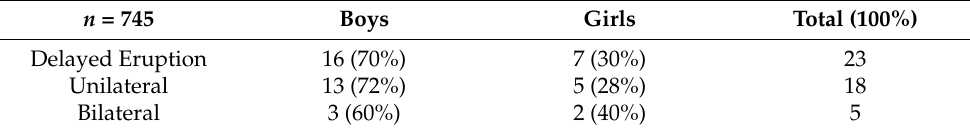
Table 1. Frequency distribution of delayed eruption cases according to gender. Delayed Eruption 23 Gender (3.09%)